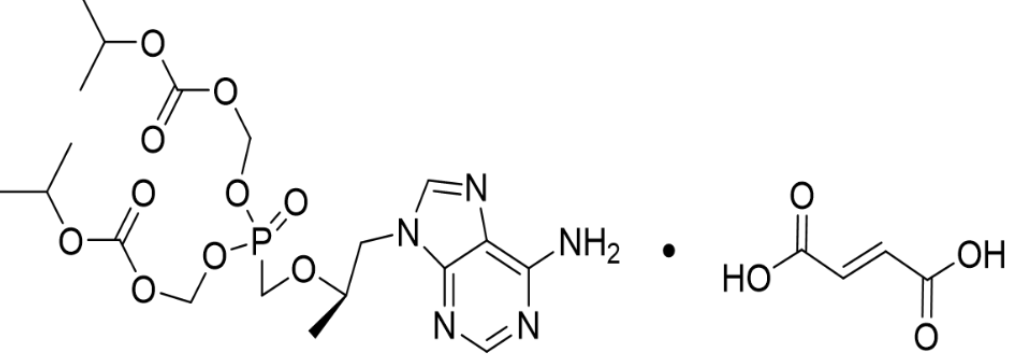
Figure 1. Chemical structure of tenofovir disoproxil fumarate (TDF).